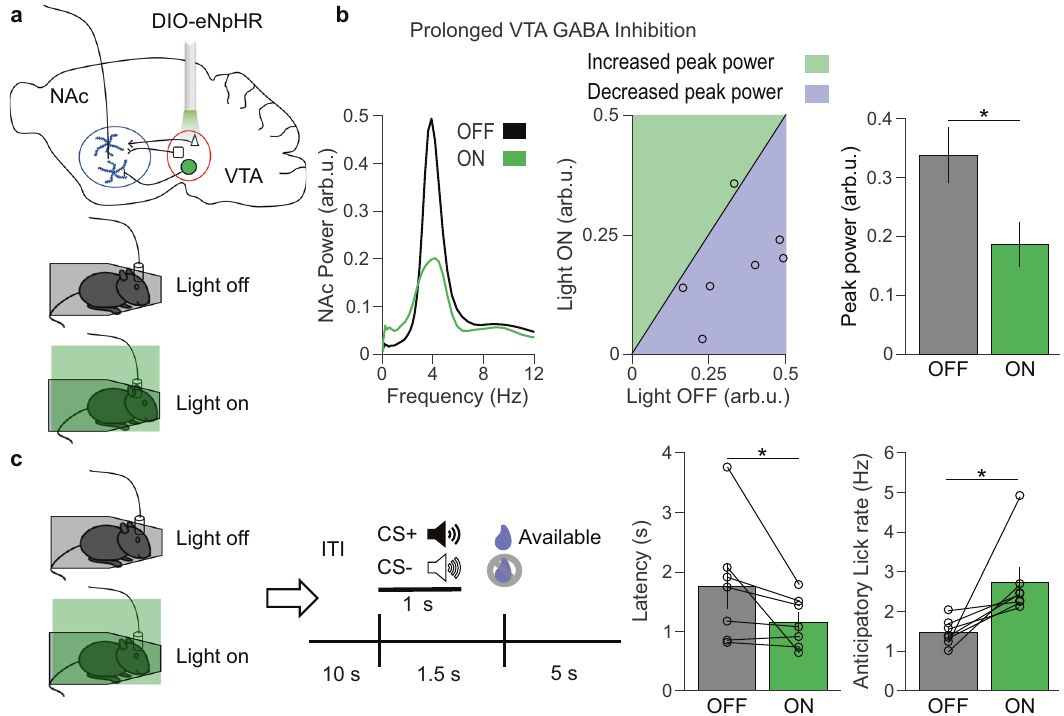
Fig. 5 Prolonged VTA GABA inhibition during restraint decreases low-frequency NAc oscillations and rescues reward-seeking behavior. a Experimental design. b Left: example NAc LFP spectra during light off (black) and light on (green) sessions. Center: relationship between peak 4 Hz NAc power during light off and light on sessions, with a line of equality for reference. Right: summary of data from the center panel. Prolonged VTA GABA inhibition reduced peak 4 Hz NAc power (* P = 0.014 two-tailed paired t test, n = 7 mice). Data are mean ± s.e.m. c Left: experimental design. Right: Prolonged VTA GABA inhibition during restraint improved reward retrieval latency and anticipatory lick rate (* P = 0.031 and * P = 0.016, two-tailed signed- rank test, n = 7 mice). Data are mean ±